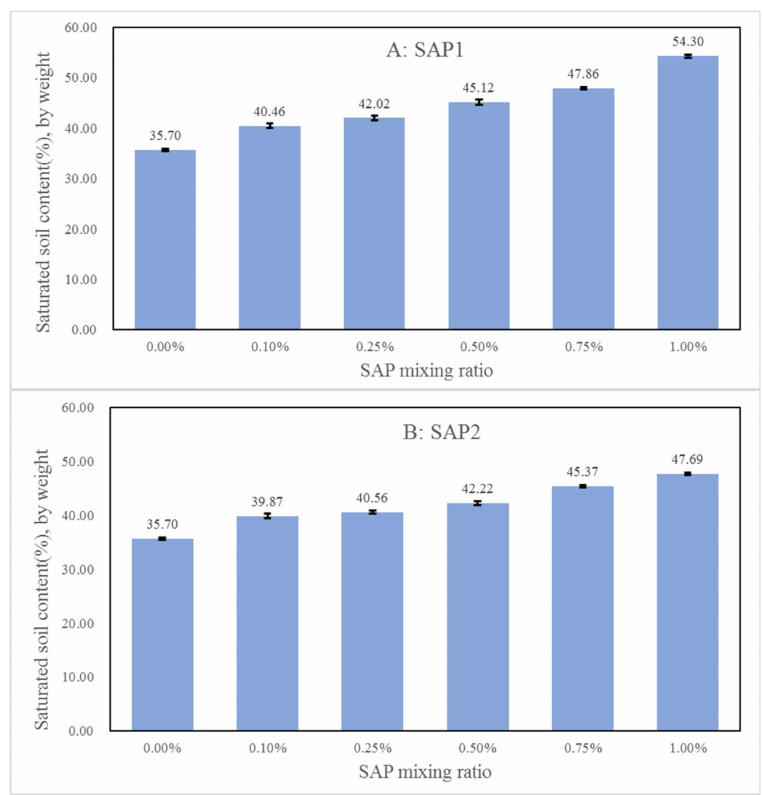
Figure 2. Saturated soil water content of superabsorbent polymer (SAP) composite cinnamon soil with di ff erent SAP mixing ratios. The controlled group with raw cinnamon soil was the one with a mixing ratio of 0.00%. Panel ( A ) shows the saturated soil water content of SAP1, and Panel ( B ) shows the saturated soil water content of SAP2. The error bars are the standard deviation of soil water content with five times measurement